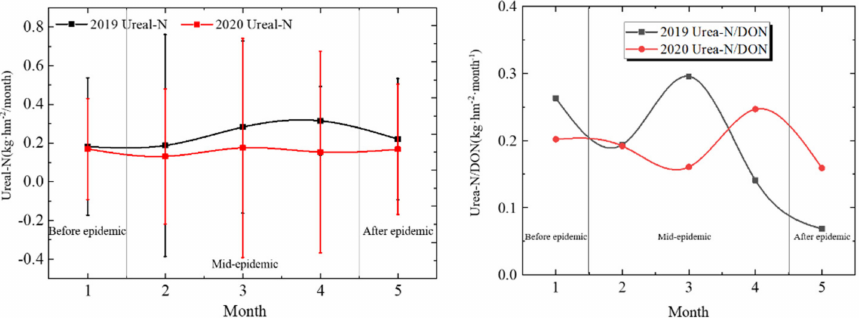
Figure 5. Urea-N around COVID-19